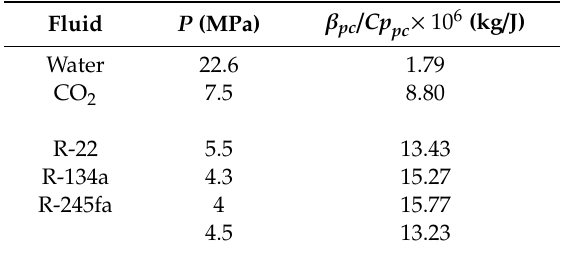
Table 4. The ratio of β to Cp for water, carbon dioxide, and organic fluids.